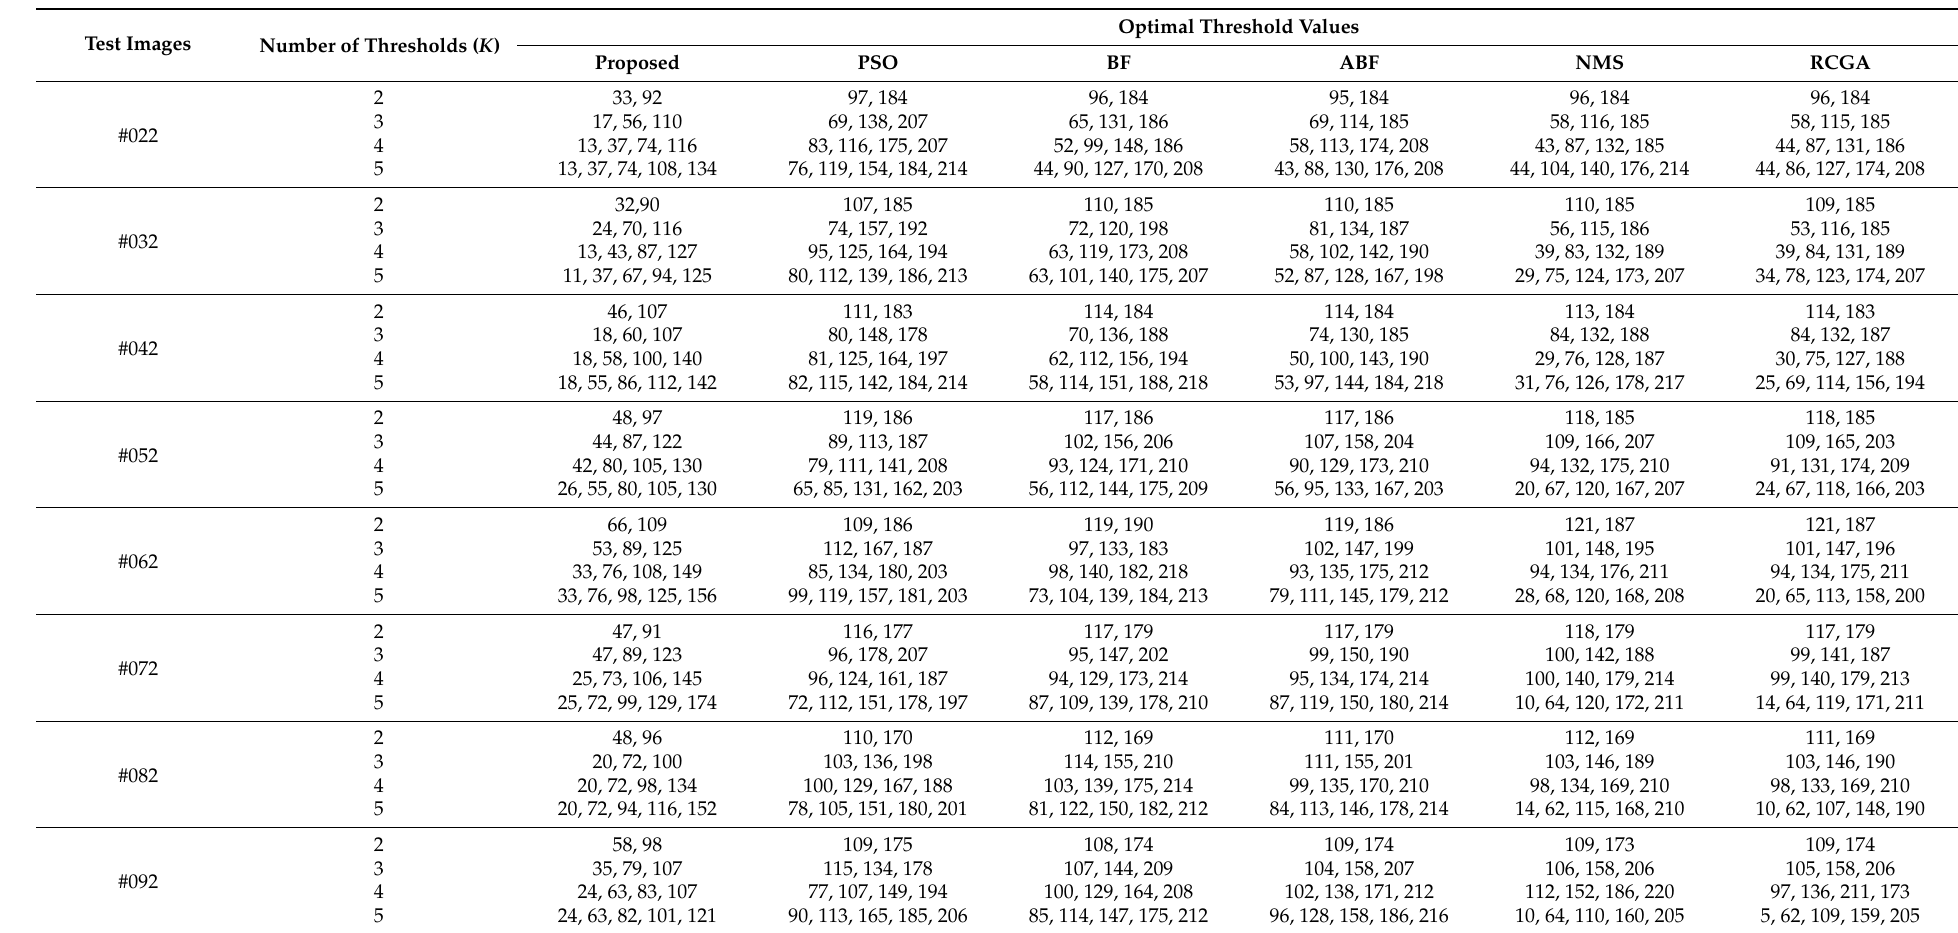
Table 3. Comparison of optimal threshold values obtained by applying different segmentation algorithms to the test images. Test